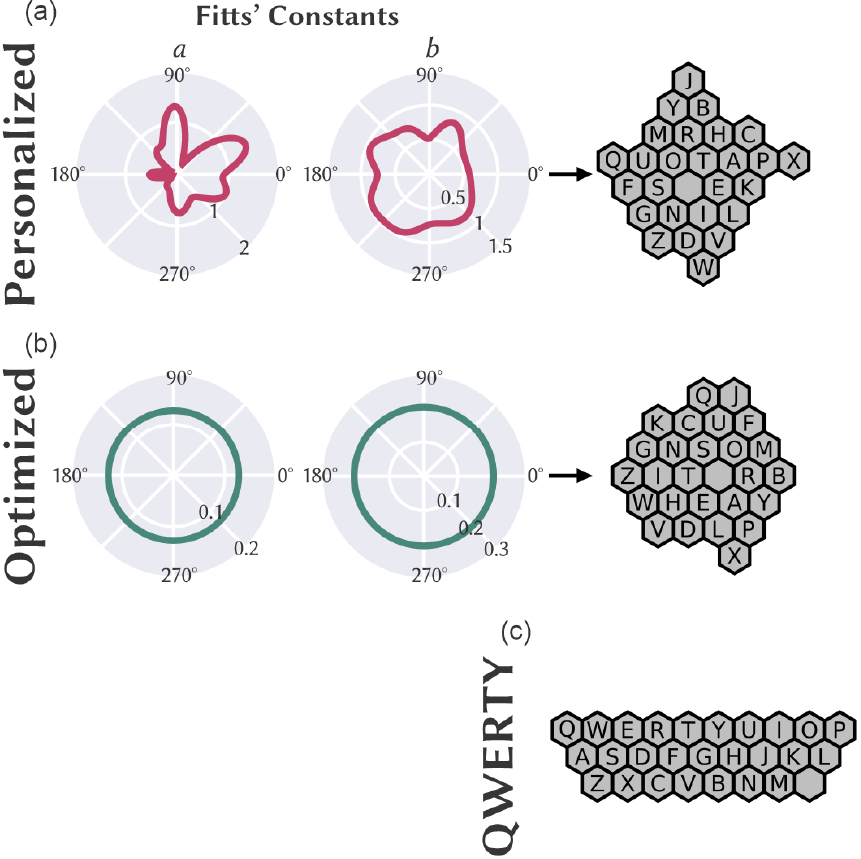
Figure 2. Keyboards used for study and their generation from Fitts’ Law constants when relevant. ( a ) Example of Fitts’ Law constants ( left , middle ) and keyboard ( right ) for one participant. ( b ) The static Fitts’ Law constants ( left , middle ) used to generate the optimized keyboard ( right ). ( c ) The QWERTY keyboard.